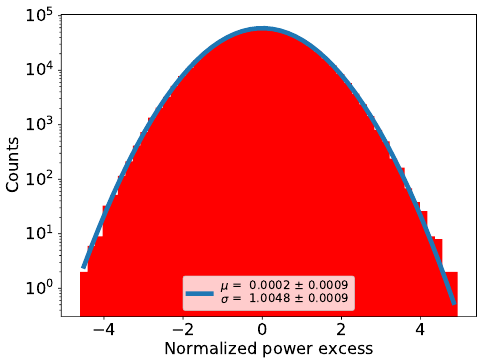
Figure 5 . Normalized histogram for all δ u